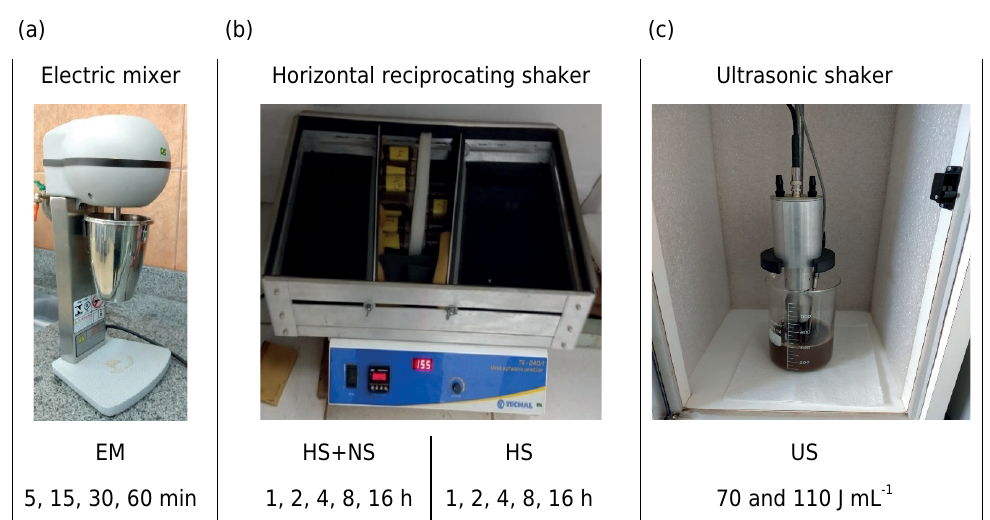
Figure 2. An electric mixer, a horizontal reciprocating shaker and an ultrasonic shaker. (a) Shaking at 12,000 rpm (EM); (b) Shaking at 150 cycles per min with nylon spheres (HS+NS) and without nylon spheres (HS); (c) Ultrasonication at 70 and 110 J mL -1 for 20 and 30 min (US),